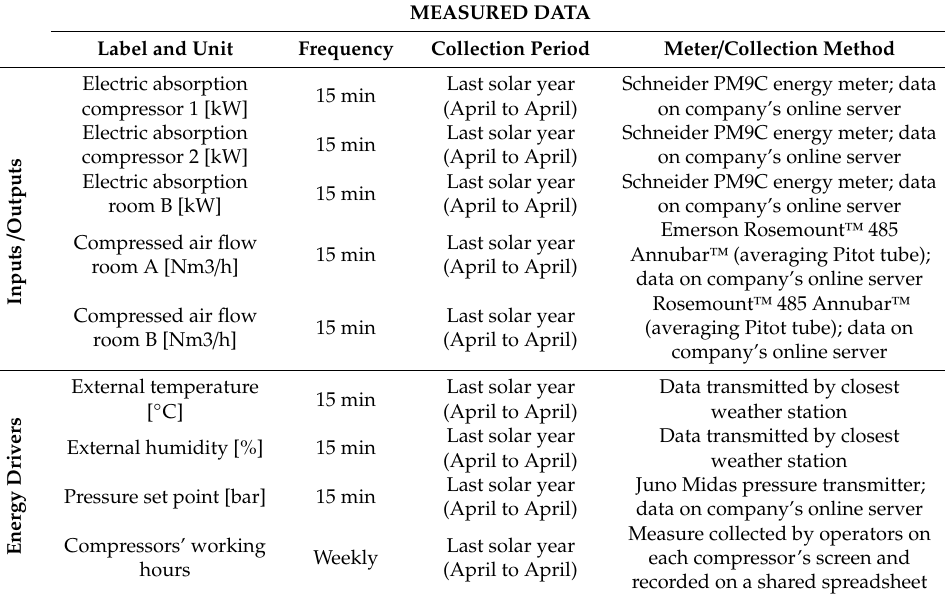
Table 1. Measurement plan.